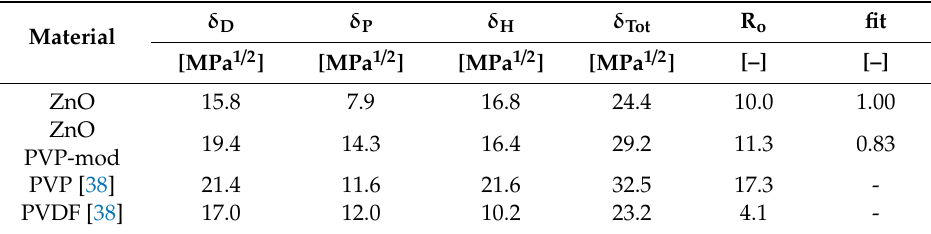
Table 5. Hansen solubility parameters for pristine and PVP-modified ZnO nanoparticles obtained from the data shown in Table 4; literature values for PVP and PVDF for